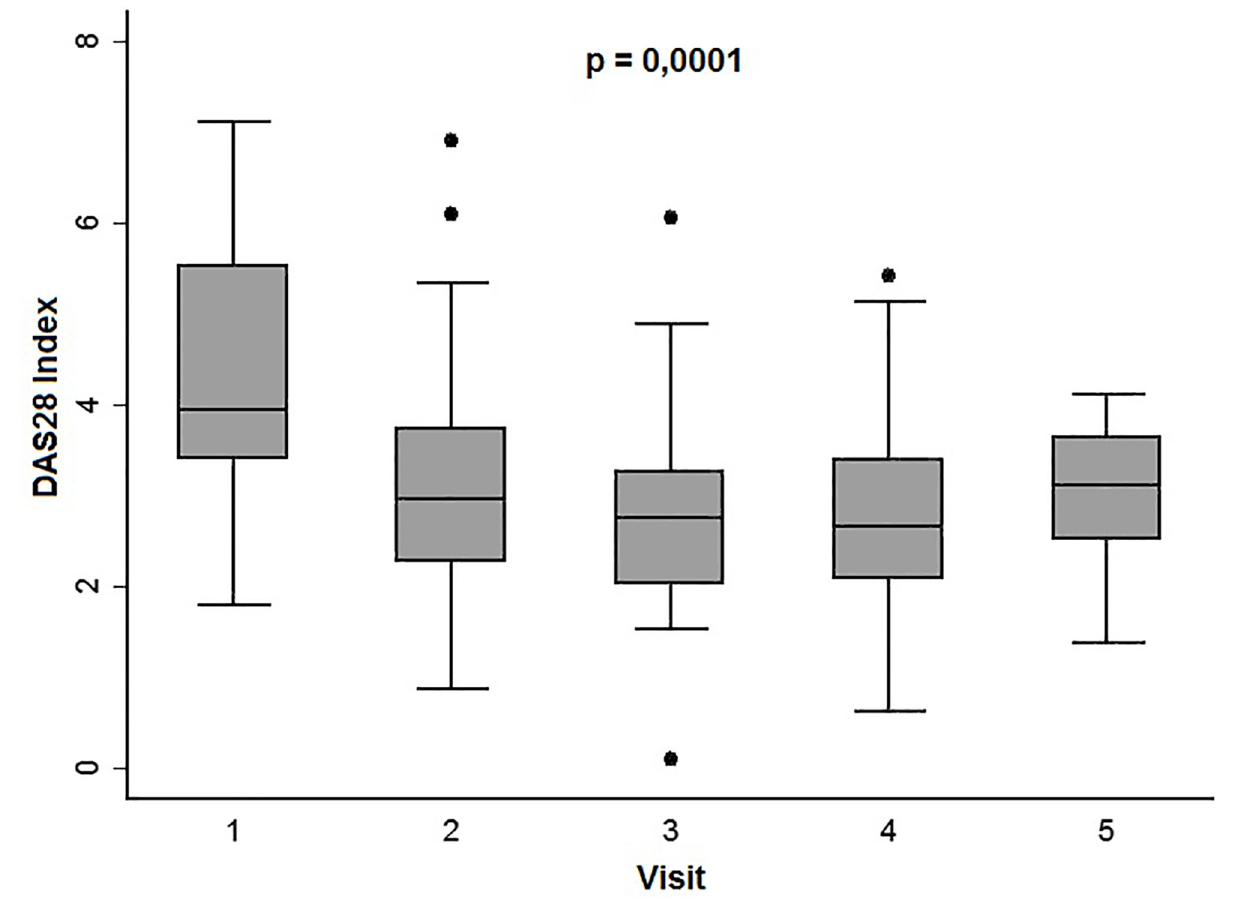
Fig 1. Progress of disease activity estimated by DAS28 at follow-up visits. Data are presented as the interquartile range (p75 upper edge of the box, p25 lower edge, p50 midline), p90 (line above the box), and p10 (line below the box). Dots represent outliers. Statistical significance was established using the Kruskal-Wallis